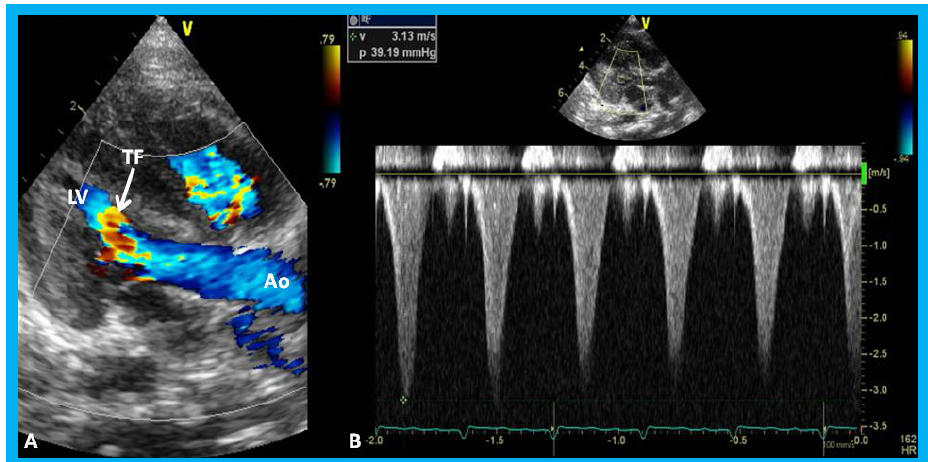
Figure 27. ( A ) Parasternal long axis, two-dimensional, and color-Doppler images demonstrating turbulent flow (TF) in the outflow tract of the left ventricle (LV) in an infant of a diabetic mother. ( B ) Continuous wave Doppler recording demonstrates a peak instantaneous gradient of 39 mmHg (see the insert in ( B )): Note the triangular pattern of the Doppler recording indicative of subaortic obstruction. Ao, Aorta.